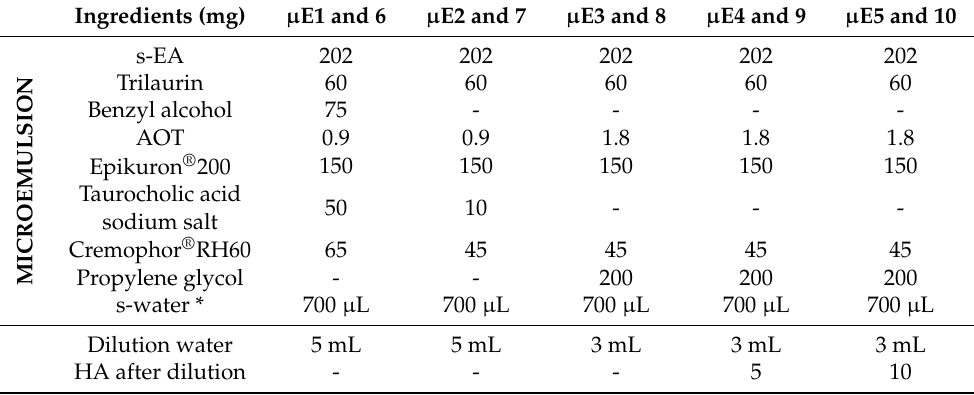
Table 1. Composition of blank ( µ E1– µ E5) and BVZ-loaded ( µ E6– µ E10) microemulsions ( µ Es); µ E6– µ E7 containing 2 mg of BVZ (corresponding to 80 µ L of ethyl acetate (EA)-saturated Avastin ® ); µ E8– µ E10 containing 4 mg of BVZ (corresponding to 160 µ L of EA-saturated Avastin ® ). * The amount of s-water was 620 µ L in µ E6– µ E7 and 540 µ L in µ E8– µ E10 as the volume of Avastin ® solution was